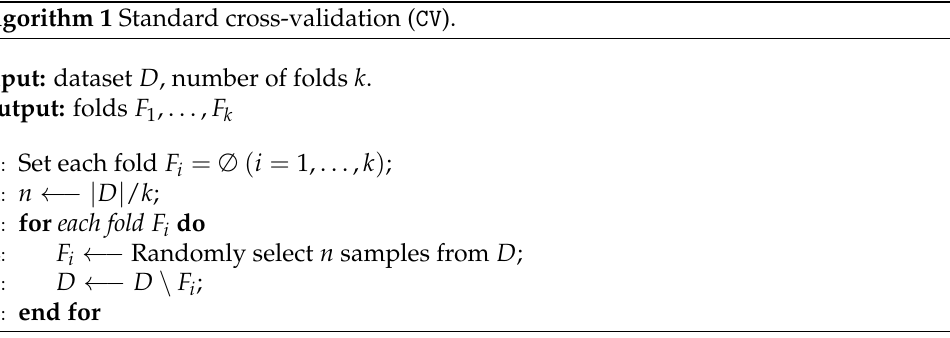
Algorithm 1 Standard cross-validation ( CV ).